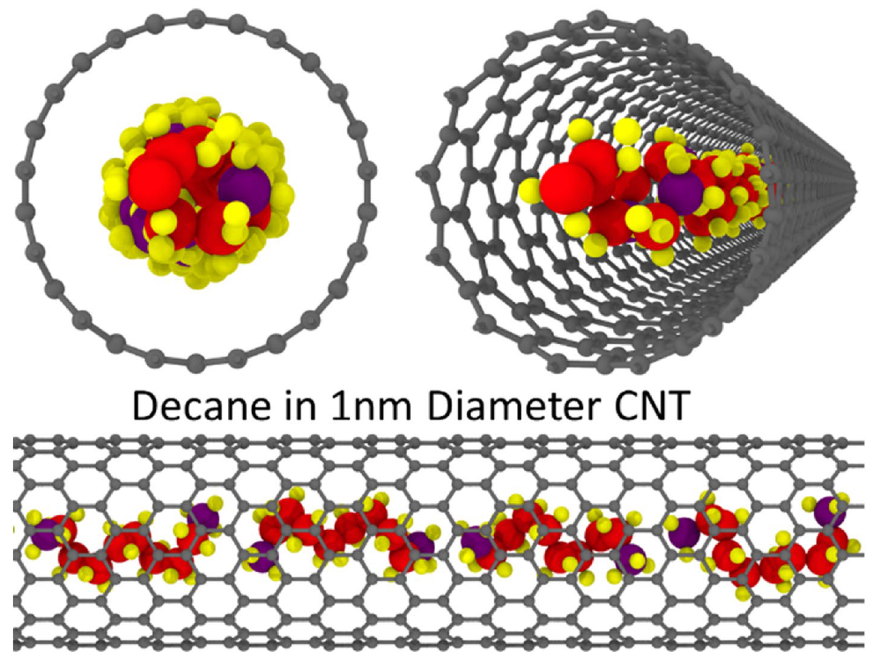
Figure 5. Different viewing angles for the flow of decane in 1 nm diameter CNT. Created using OVITO (ver:3.3.0).